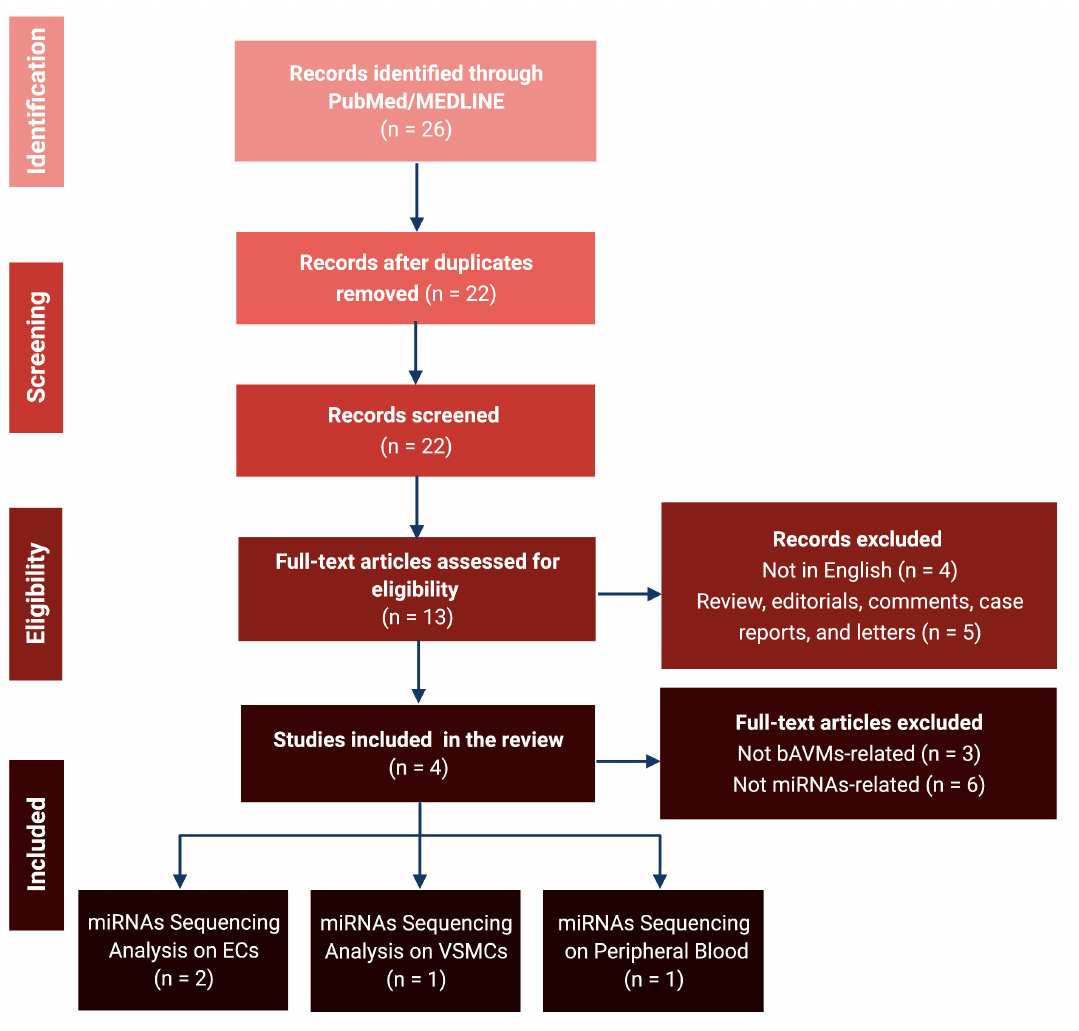
Figure 1. PRISMA flowchart for the review. bAVM: Brain Arteriovenous Malformation; ECs: En- dothelial Cells; miRNA: microRNA; VSMCs: Vascular Smooth Muscle Cells.